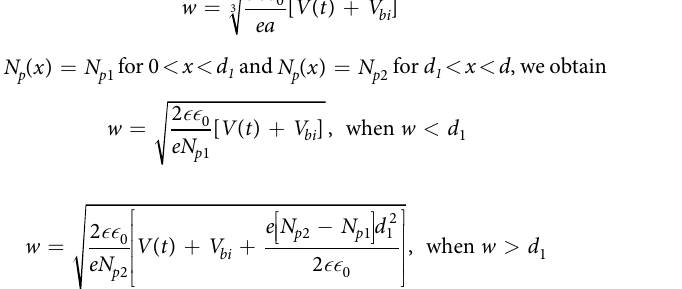
Drift-diffusion simulations.